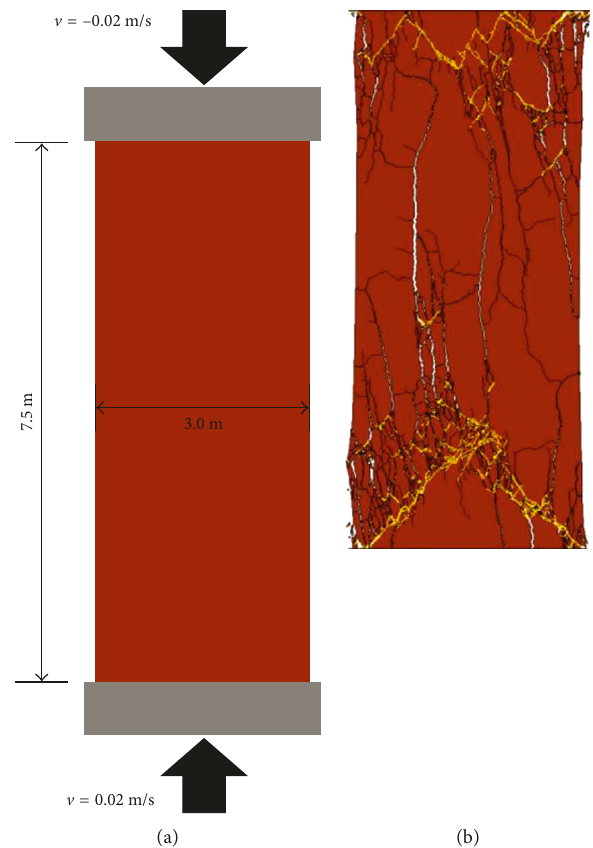
Figure 3: Unconfined compressive strength (UCS) test for the calibration of the FDEM elastic microparameters based on the deformability properties of the LdB granite. (a) The initial UCS configuration and (b) the UCS specimen at its postpeak condition. Black fractures indicate failure in tension (Mode I), and yellow fractures indicate failure in shear (Mode II).